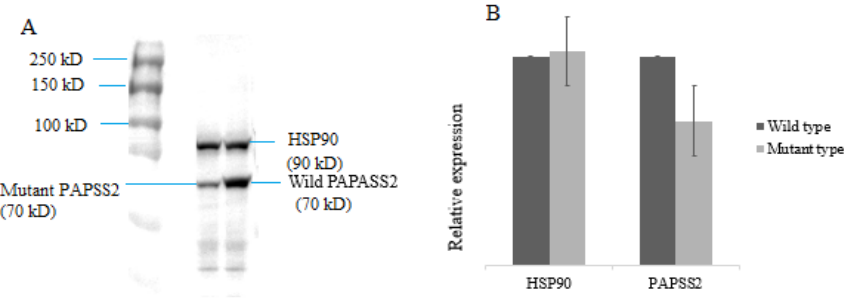
Figure 3. Western blotting and relative Protein expression. ( A ) The 293T cells were transiently transfected with expression plasmids for the PAPSS2 target protein with a DDK-Myc tag. Cells were collected 48 h later, and equal amounts of the whole-cell lysates were subjected to immunoprecipita- tion with antibodies against the target protein. Lane 2 for mutant type PAPSS2 protein, lane 3 for wild target protein. Lane 1 protein molecular marker of 250 kD. ( B ). Relative expression of proteins. Mutated PAPSS2 protein showing higher expression at 70 kD when it was compared to wild PAPSS2. Housekeeping gene HSP90 showing similar expression in both plasmids (wild type and